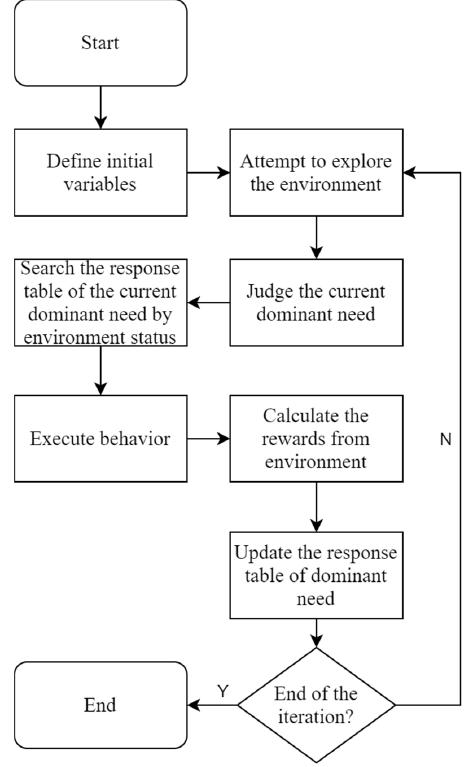
Figure 3. Diagram of algorithm flow.